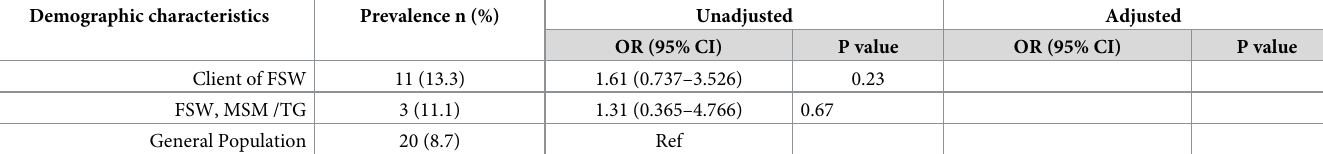
S1 Table. Results showing correlation between covariates and collinearity statistics. (DOCX) S1